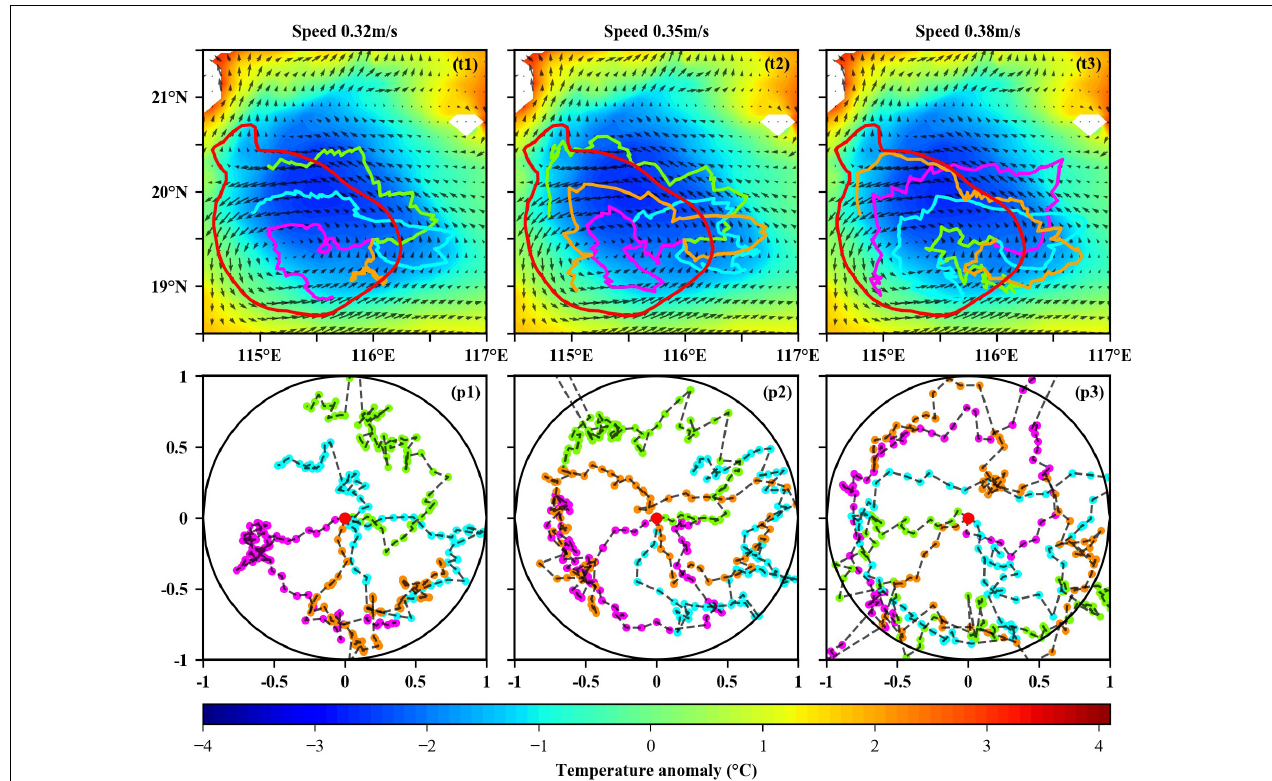
FIGURE 9 | The results of gliders at the speed of 0.32 m/s, 0.35 m/s, and 0.38 m/s used to track the target eddy on July 24, 2015. Similarly, the first column is the trajectory of gliders, the second column is the normalized position of